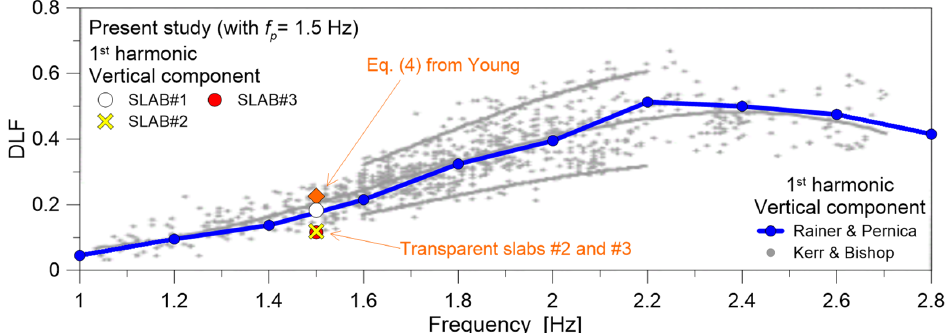
Figure 9. Present experimental derivation of average DLF values (first harmonic of vertical force component) for a single adult pedestrian volunteer under normal walks ( f p = 1.5 Hz), and comparison with selected literature outcomes, such as Rainer & Pernica [7], Kerr & Bishop [24], Young [29]. Present average DLF values calculated for a single adult pedestrian, based on eight walking records for SLAB#1, 10 for #2 and nine for #3.